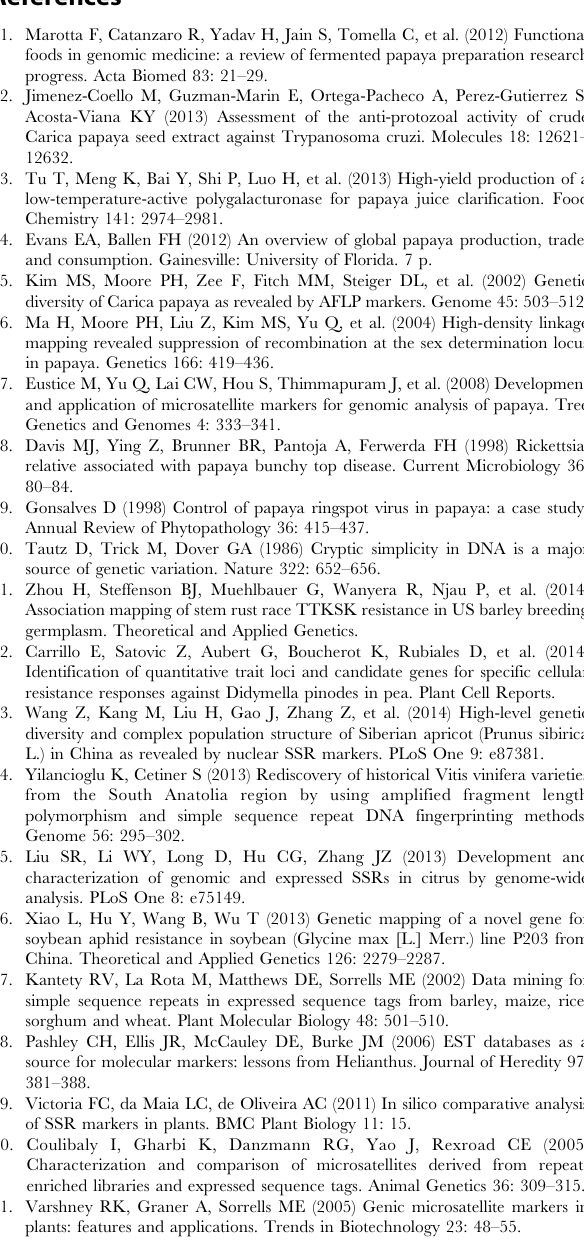
Table S8 SSR markers for transcriptional/ethylene genes. (XLS) Table S9 Primer pairs used for polymorphism analysis. Genes related with cell wall metabolism and transcriptional yellow,